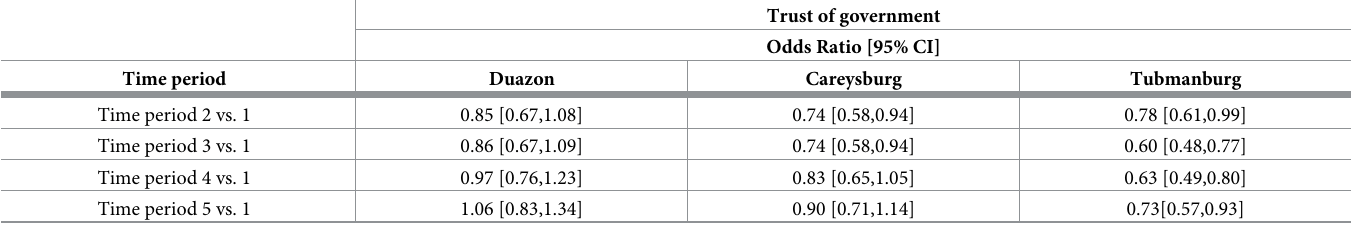
Table 4. Odds ratios and 95% confidence intervals for trust in Time Periods 2–5 vs. in Time Period 1 for trust of the government in Duazon (peri-urban, high expo- sure), Careysburg (rural, low exposure), and Tubmanburg (urban, high incidence). Odds ratios were calculated from an ordinal logistic regression model. In the first entry, respondents of Duazon were 15% (1–0.92) less likely to report a higher trust rating in Time Period 2 as compared to Time Period 1.